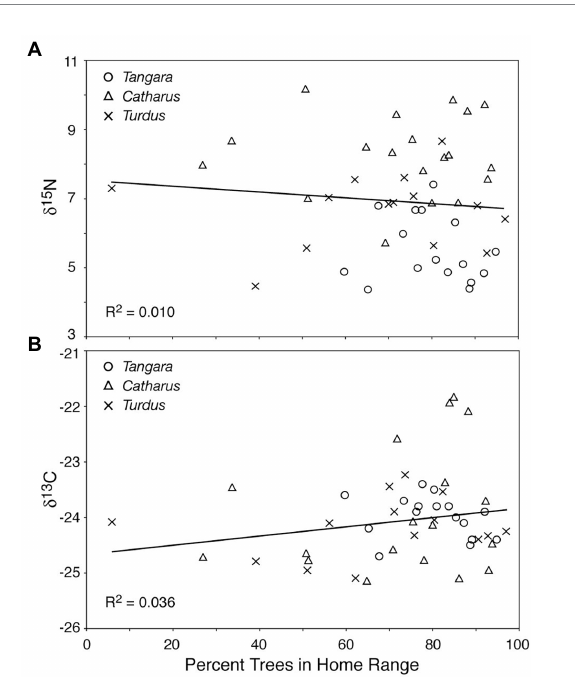
FIGURE 5 Effect of percent tree cover in radio-tracked birds’ home ranges on the nitrogen (A) and carbon (B) isotopic composition of bird feathers. Regression statistics for the entire bird community (rather than single species) are provided because bivariate analyses of isotopic composition versus percent tree cover for each species were similar ( r 2 < 0.10; p > 0.05 for both δ 13 C and δ 15